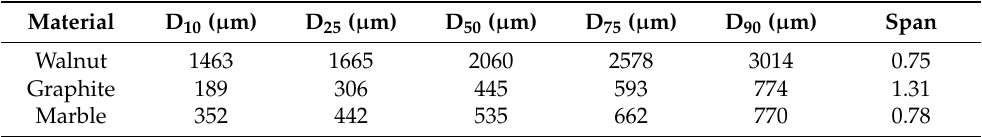
Table 4. Dry cumulative distributions values for all granular